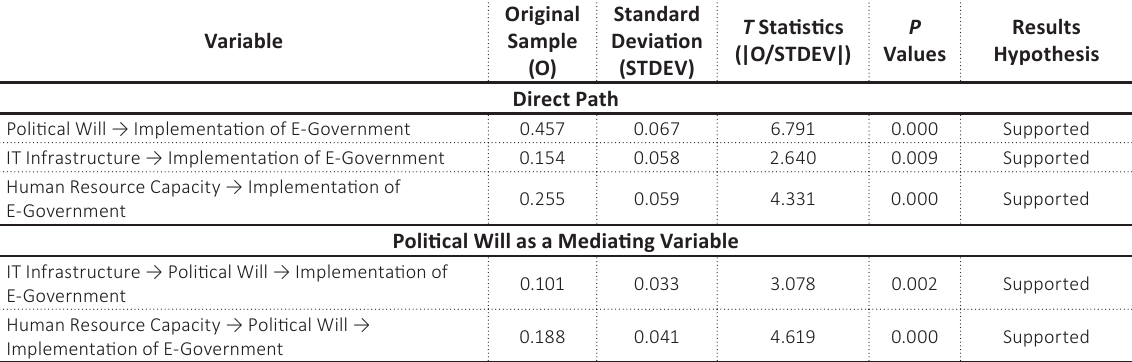
Table 4. Bootstraping test